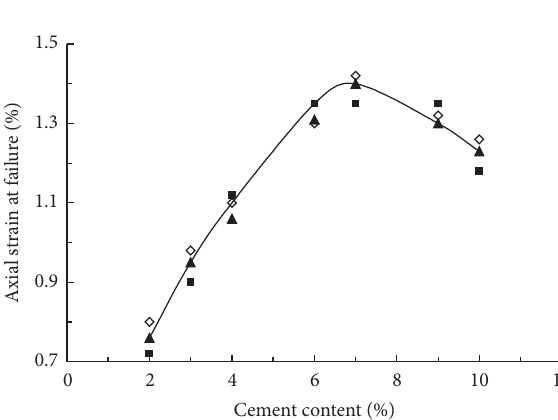
Figure 14: Variation of failure strain for different cement contents.